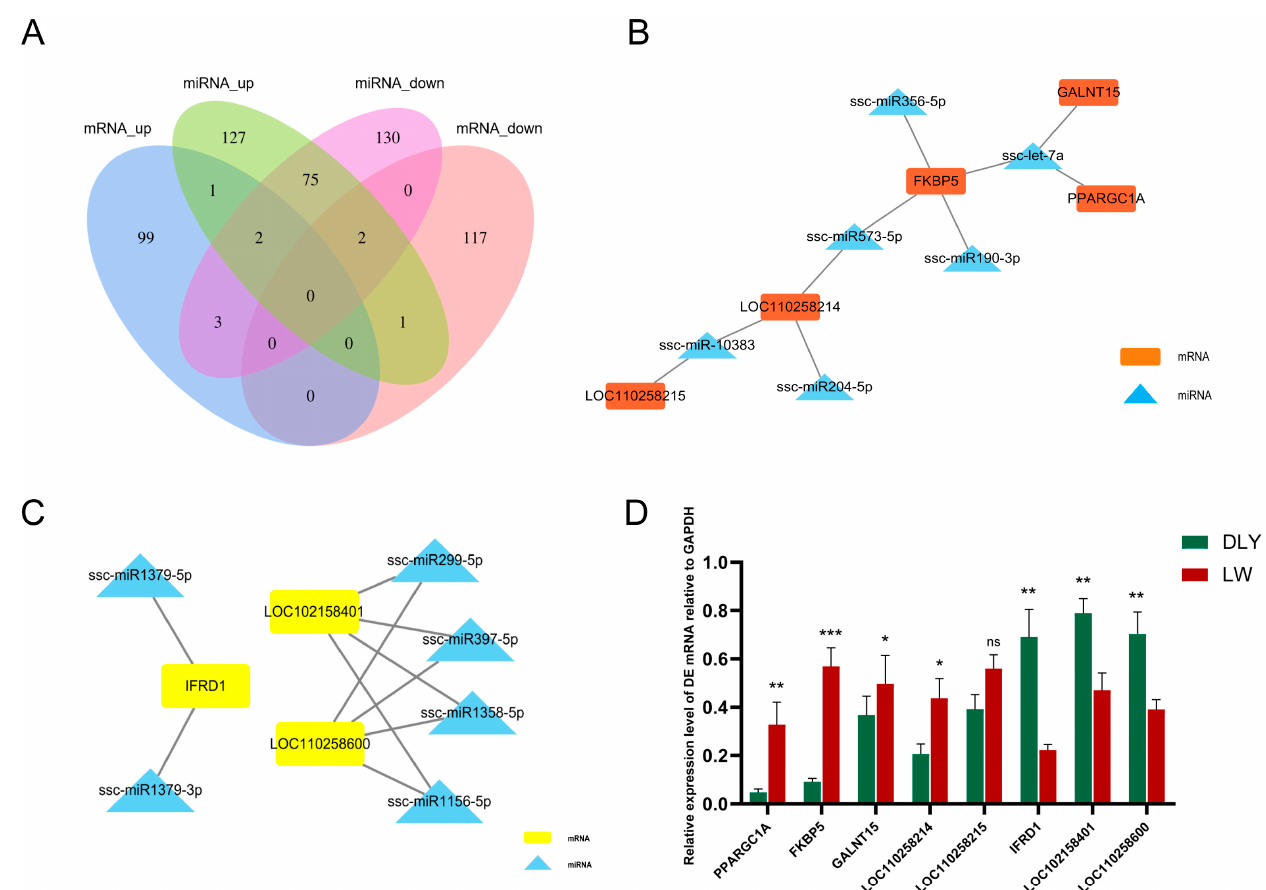
Figure 6. mRNA-miRNA network constructed with DE miRNAs and DE mRNAs in the Longissimus dorsi muscle of pigs. ( A ) Venn plots showing the number of overlapping targeted genes of DE miRNAs and DE mRNAs. ( B ) Cytoscape showing the interactions of upregulated DE mRNA and downregulated DE miRNA, five mRNAs and six miRNAs are targeted in this sub-network. The red and blue nodes represent mRNAs and miRNAs, respectively. ( C ) Cytoscape showing the interactions of downregulated DE mRNA and upregulated of DE miRNA; three mRNAs and six miRNAs are targeted in this sub-network. The yellow and blue nodes represent mRNAs and miRNAs, respectively. ( D ) Verification of the above DE mRNAs. * p < 0.05, ** p < 0.01, *** p < 0.001; ns, not